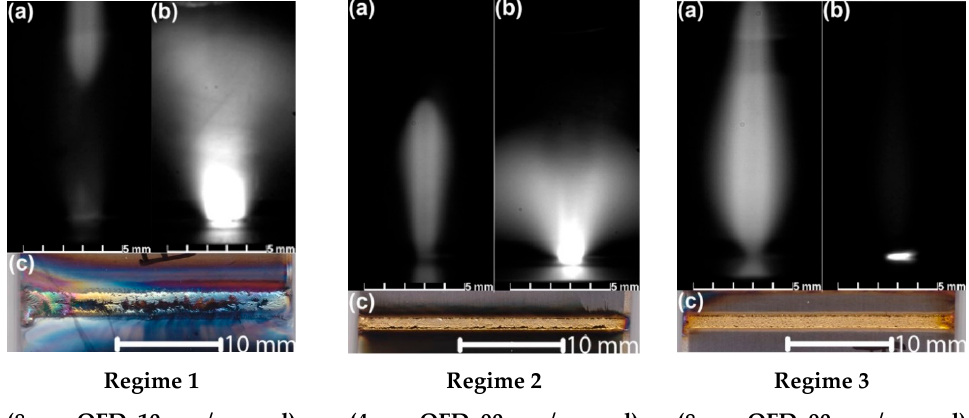
Figure 4. ( a ) Atomic nitrogen species (CCD image), ( b ) atomic titanium species (CCD image), and ( c ) photograph of the top surface of nitrided trail shown for Regime 1 (left), Regime 2 (middle), and Regime 3 (right) during LSP nitriding. Reprinted with permission from Ref. [108]. Copyright 2012 IOP Publishing.